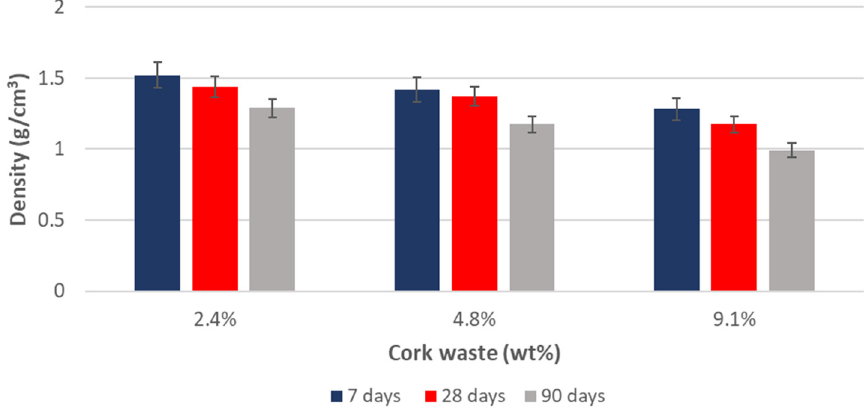
Figure 5. Apparent density of all geopolymers after 7, 28 and 90 days.